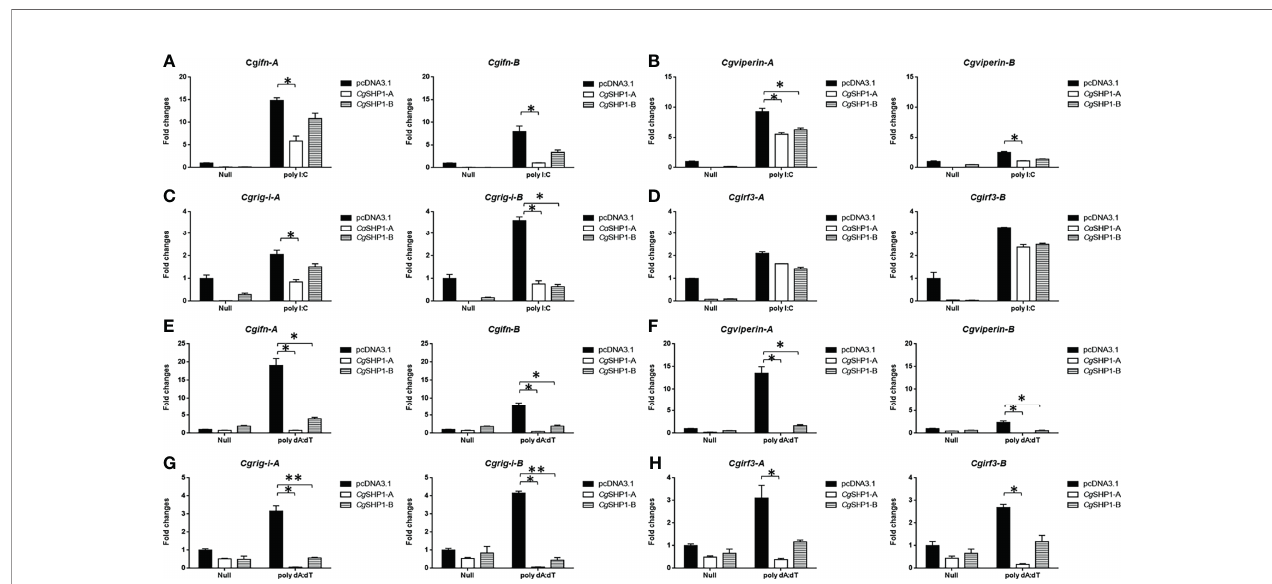
FIGURE 5 | Cg SHP1-A and Cg SHP1-B inhibit the expression of gibel carp IFN and IFN-related genes induced by 1 m g/ml poly I:C (A – D) or poly dA:dT (E – H) in GiCB cells. eef1a1l1 was used as control and the relative expression is represented as fold induction relative to the expression level in control cells (set to 1). Each bar represents mean ± SEM (n = 3). The asterisks indicate the signi fi cant differences (* p < 0.05, ** p <